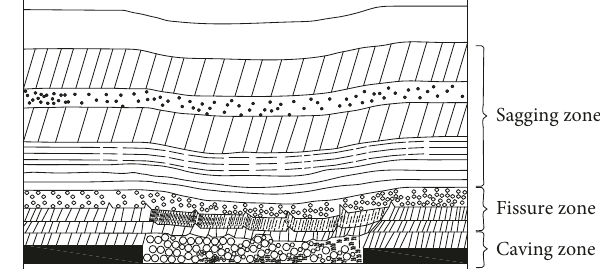
Figure 17: Three zones of overlaying rock